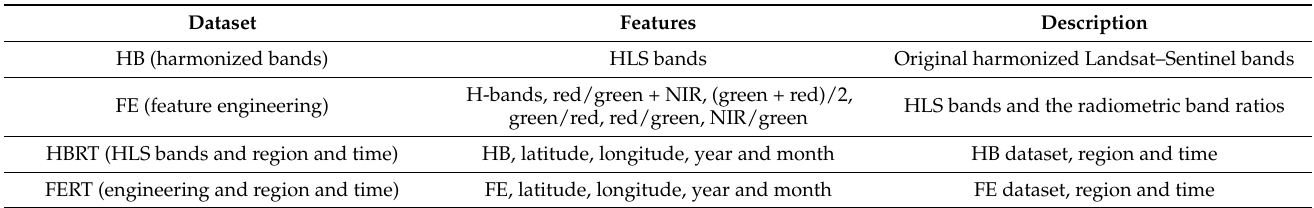
Table 7. Summary of the studied